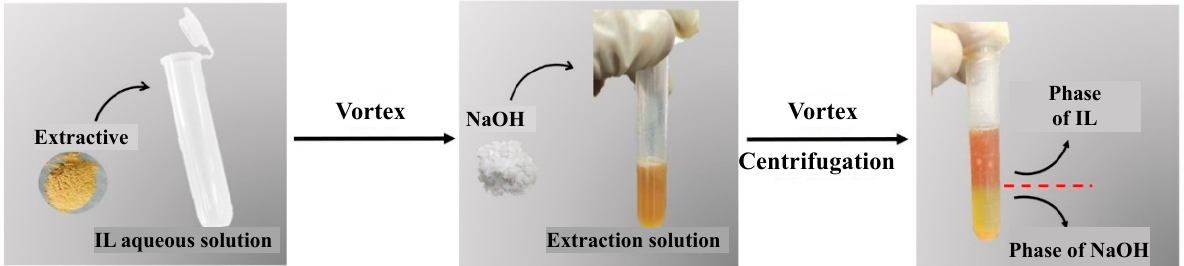
Figure 1. Flow chart for extraction and purification of total saponins from Momordica charantia L. by ionic liquid-based aqueous biphasic systems (IL-based ABS) based high hydrostatic pressure (HHP) extraction.